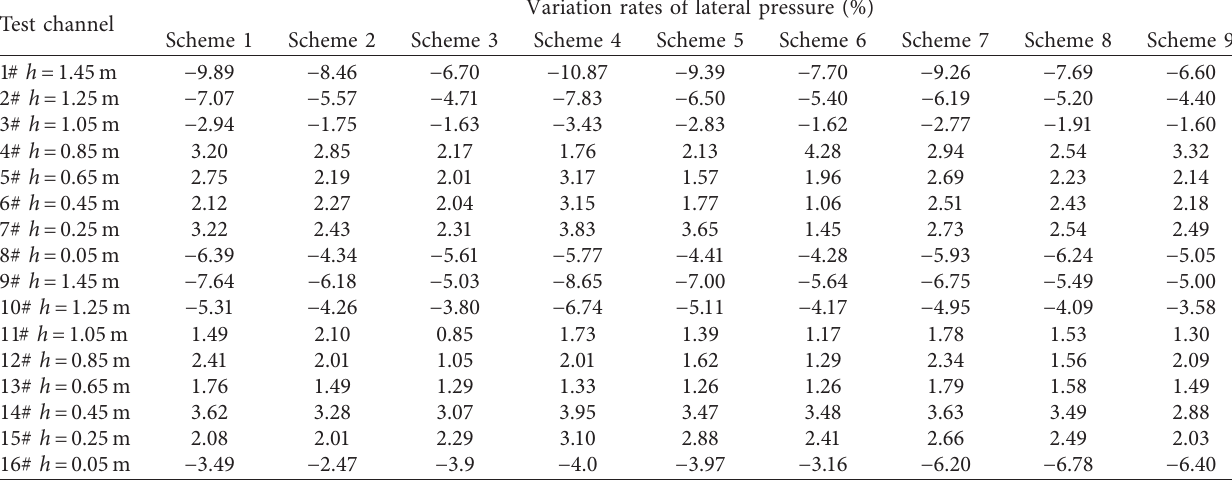
Table 6: The variation rates of lateral pressure under different stoping sequences and granular gradings.